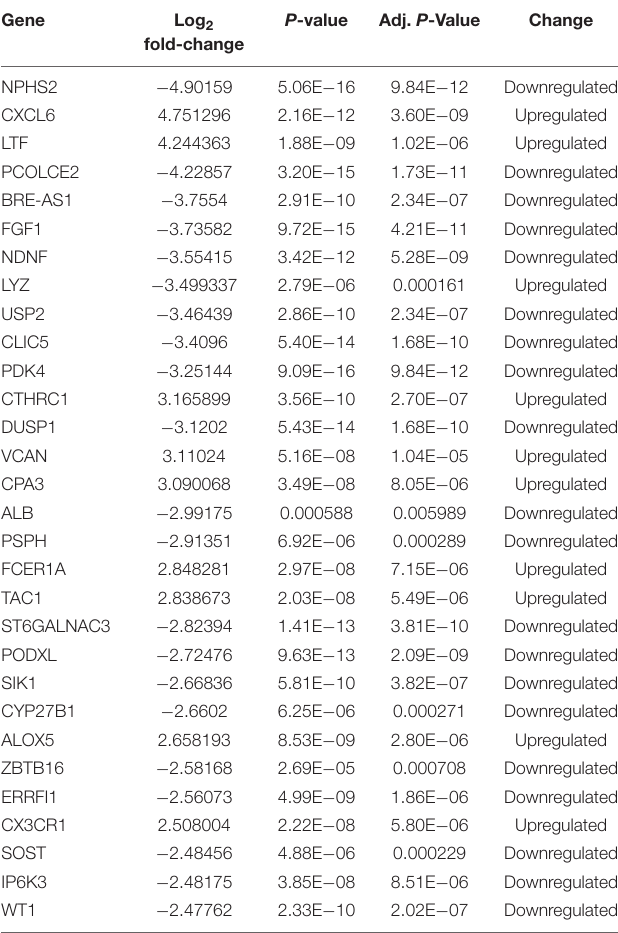
TABLE 1 | Top 30 DEGs identified in gene expression microarray analysis of seven patients with DKD and seventeen LDs. Gene Log 2